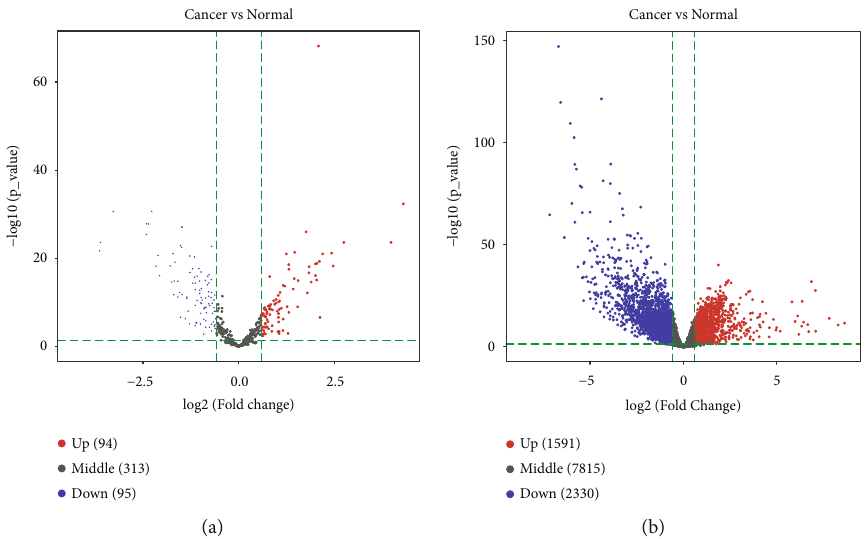
Figure 2: Identi fi cation of DEmiRNAs (a) between GC tissue ( n = 436 ) and adjacent tumor-free gastric tissue ( n = 41 ) samples and DEmRNAs (b) between GC tissue ( n = 375 ) and adjacent tumor-free gastric tissue ( n = 32 ) samples by di ff erentially analyzing the raw data deposited in TCGA-STAD.